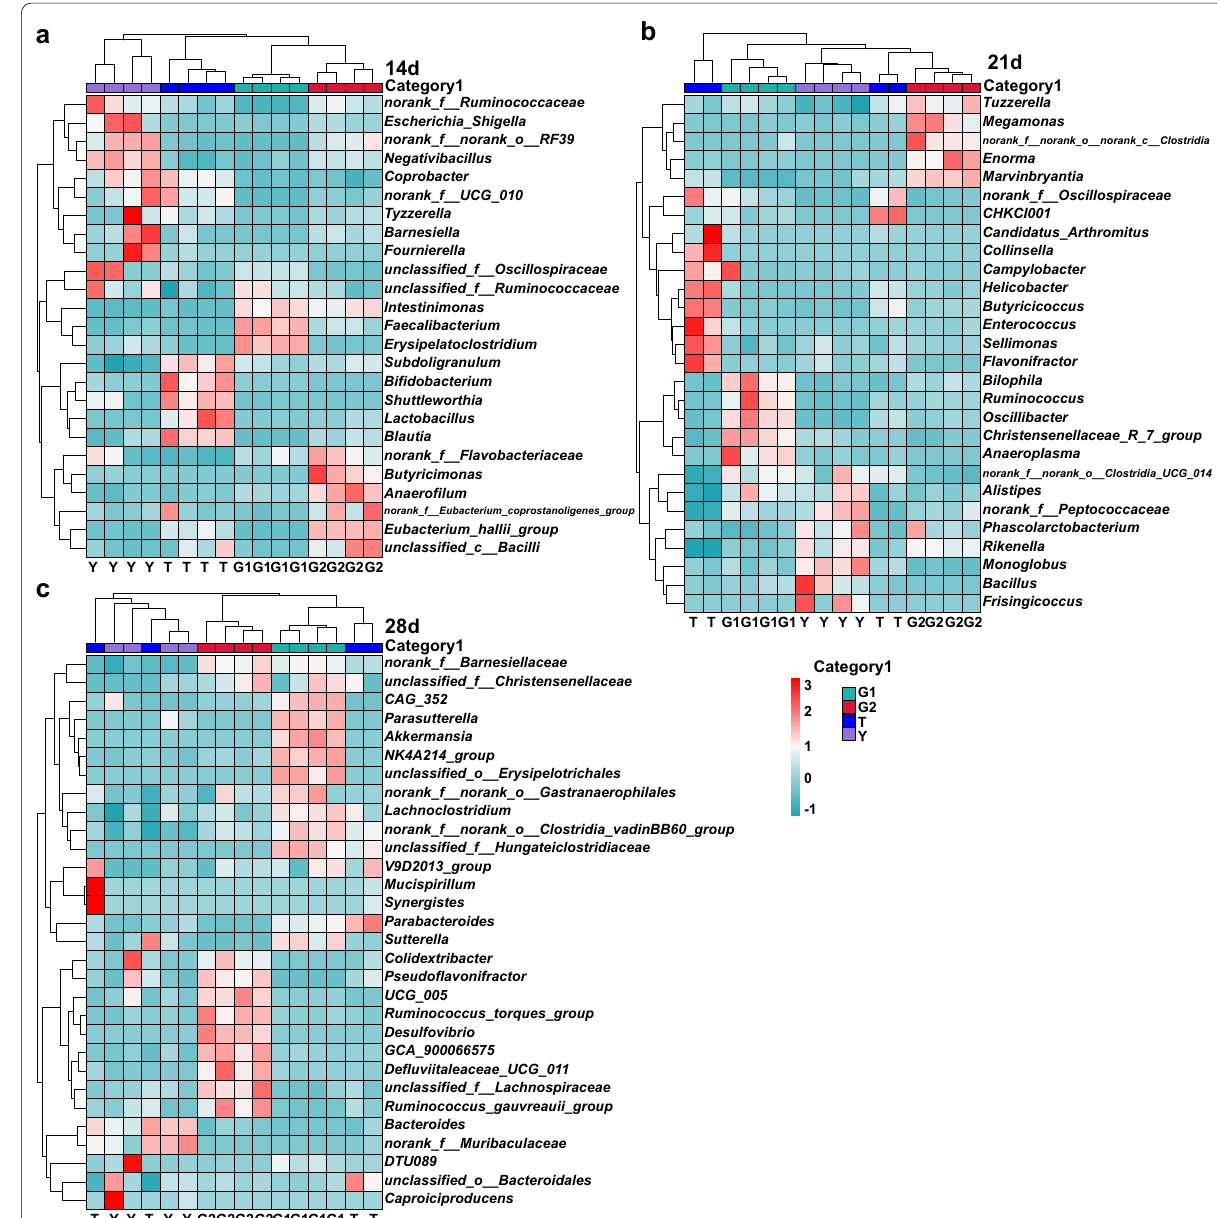
Fig. 8 Hierarchically clustered heat map for the significantly different bacterial genera in cecal contents of 14 day old broiler a , 21 day old broilers b and 28 day old broilers c . Heat map indicated 83 bacterial taxa were identified by LEfSe (LDA > 3) in broilers at 14 days of age (n of age (n 28) b and 28 days of age (n 30) c cecum microbiome. The top 1000 features were used for lefse analysis. Heat map shows the average = = relative abundances on a